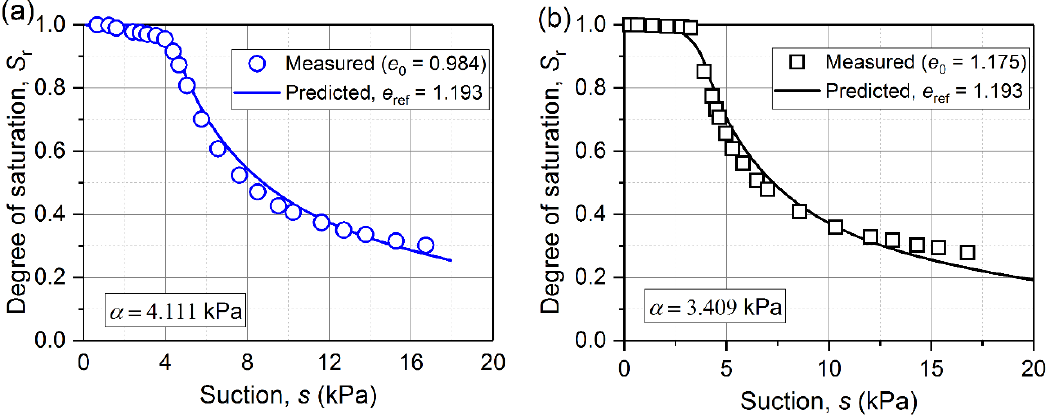
Figure 8. Measured and predicted SWRC for a sandy loam at ( a ) e 0 = 0.984; ( b ) e 0 = 1.175.